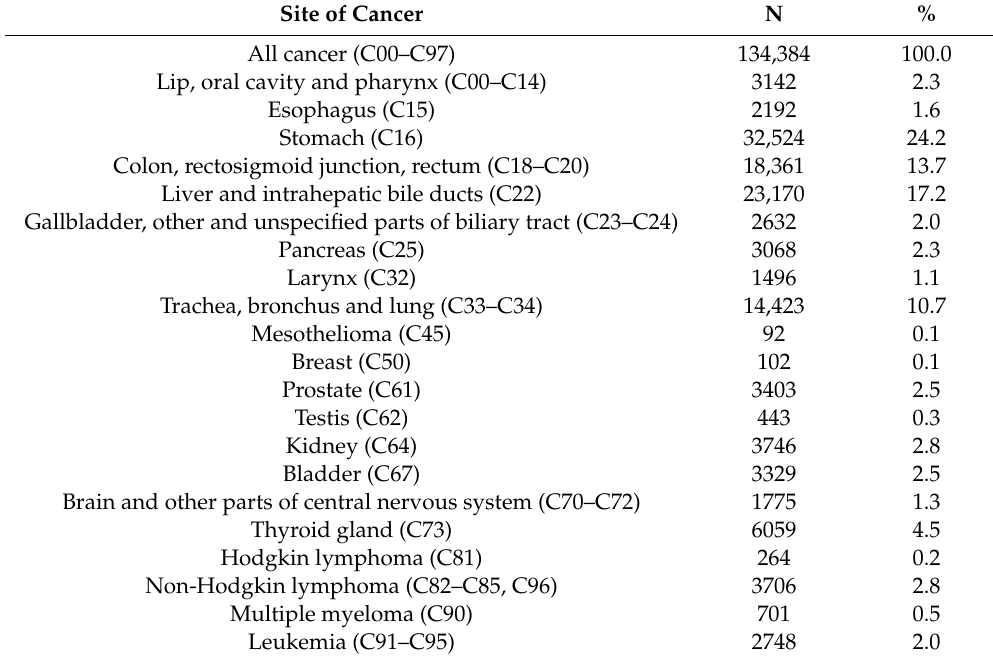
Table 2. Distribution of cancer sites in the study